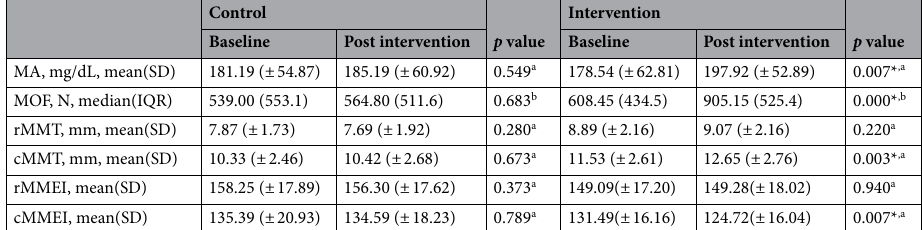
Table 3. Intra-group comparison in the control (n = 27) intervention (n = 26) groups before and after intervention. SD standard deviation, IQR interquartile range, MA masticatory ability, MOF maximum occlusal force, rMMT masseter muscle thickness at rest, cMMT masseter muscle thickness during contraction, rMMEI masseter muscle echo intensity at rest, cMMEI masseter muscle echo intensity during contraction. * p -value < 0.05. a Paired t test. b Wilcoxon signed-rank